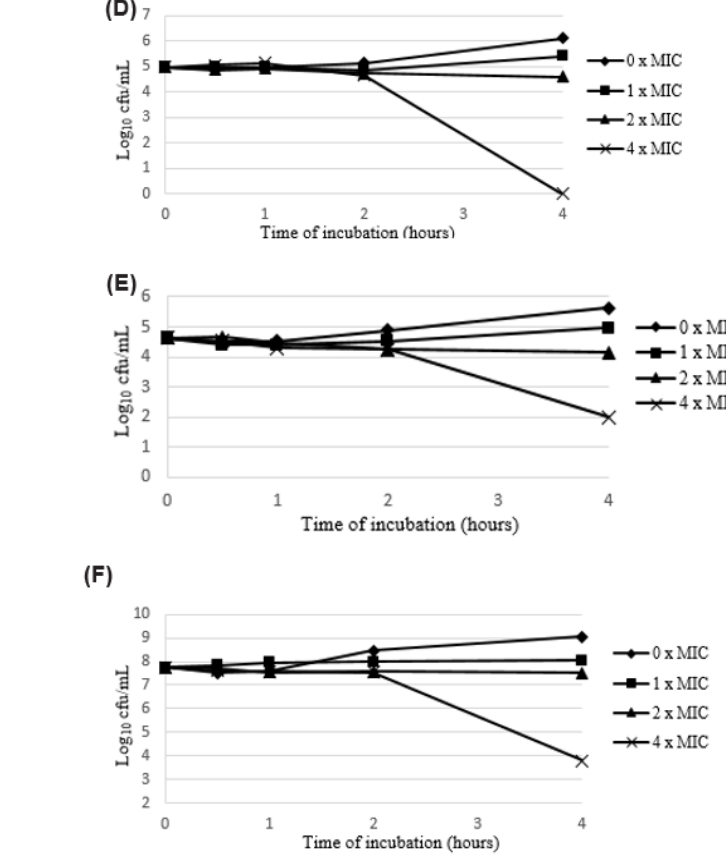
Figure 2. Time-kill curve of MRSA ATCC 700699 after exposure to ( A ) compound 8 and ( B ) compound 9 at 0 × MIC (0 mg/mL), 1 × MIC (0.156 mg/mL), 2 × MIC (0.313 mg/mL), and 4 × MIC (0.625 mg/mL), as well as ( C ) compound 10 at 0 × MIC (0 mg/mL), 1 × MIC (0.313 mg/mL), 2 × MIC (0.625 mg/mL), and 4 × MIC (1.25 mg/mL). Time-kill curve of clinical MRSA 172918 after exposure to ( D ) compound 8 at 0 × MIC (0 mg/mL), 1 × MIC (0.078 mg/mL), 2 × MIC (0.156 mg/mL), and 4 × MIC (0.312 mg/mL), ( E ) compound 9 at 0 × MIC (0 mg/mL), 1 × MIC (0.156 mg/mL), 2 × MIC (0.313 mg/mL), and 4 × MIC (0.625 mg/mL), and ( F ) compound 10 at 0 × MIC (0 mg/mL), 1 × MIC (0.313 mg/mL), 2 × MIC (0.625 mg/mL), and 4 × MIC (1.25 mg/mL).